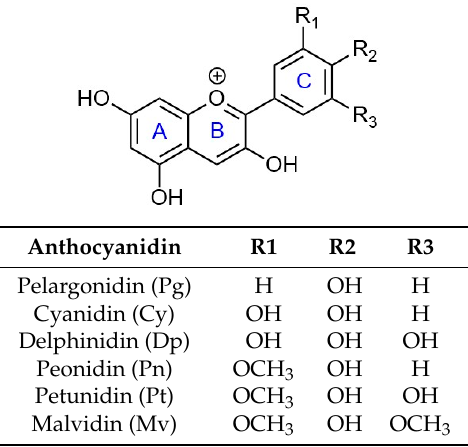
Figure 3. Flavylium ion structure and chemical groups of the anthocyanidins present in red fruits.